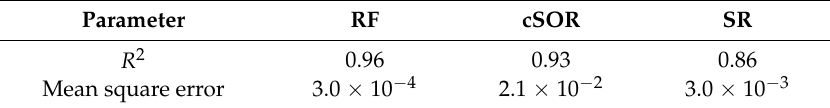
Table 5. Coefficients of determination for the three response surface models.